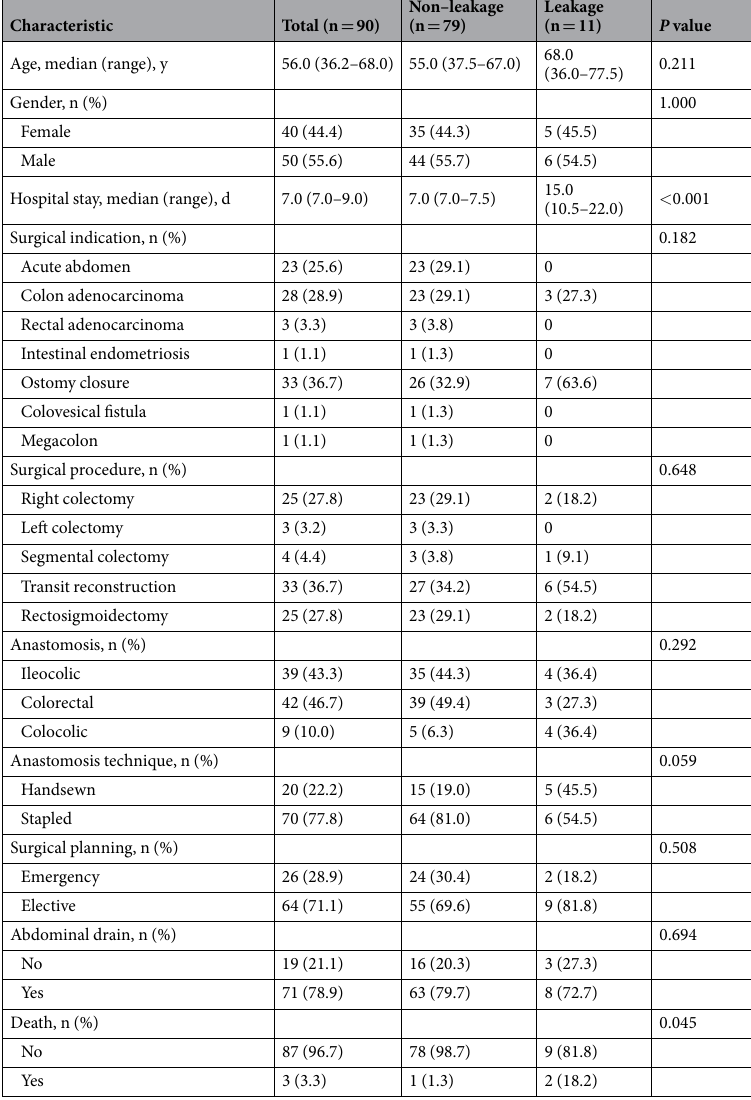
Table 1. Clinical and demographic characteristics. P -values obtained using the Mann–Whitney U